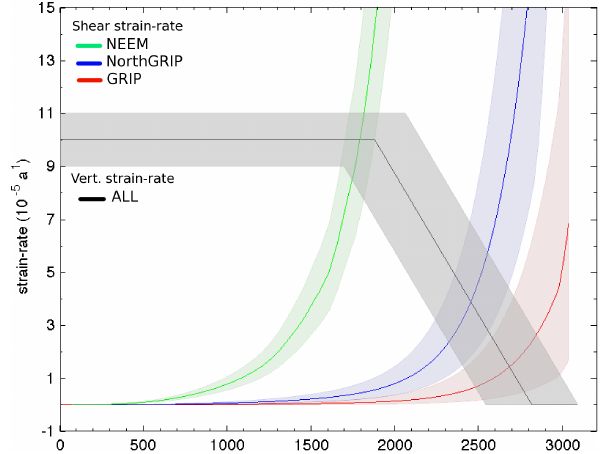
Figure 5. Comparison between the fabric profiles along the NEEM Figure 6. Evolution of the shear strain rates, D xz , along the GRIP ice core (filled symbols) and the NGRIP ice core (open symbols) (red), NGRIP (blue) and NEEM (green) ice cores with error bars. (dot: a ( 2 ) , triangle: a ( 2 ) , star: a ( 2 ) ) (Wang et al., 2002; Svens- 1 2 3 The black line represents the estimated evolution of the vertical son et al., 2009). Arrows indicate the HW climatic transition (NE: strain rate D zz , which is basically the same for all three cores re- NEEM, NG: NGRIP). Top axes: approximate age scales for both garding the error cores. Table 1. Ice thickness ( H ), annual accumulation ( a ), average annual temperature ( T yr ), ratio a/H and surface slope magnitude (d s/ d x ) in GRIP, NGRIP and NEEM ice cores (references are given in the text).